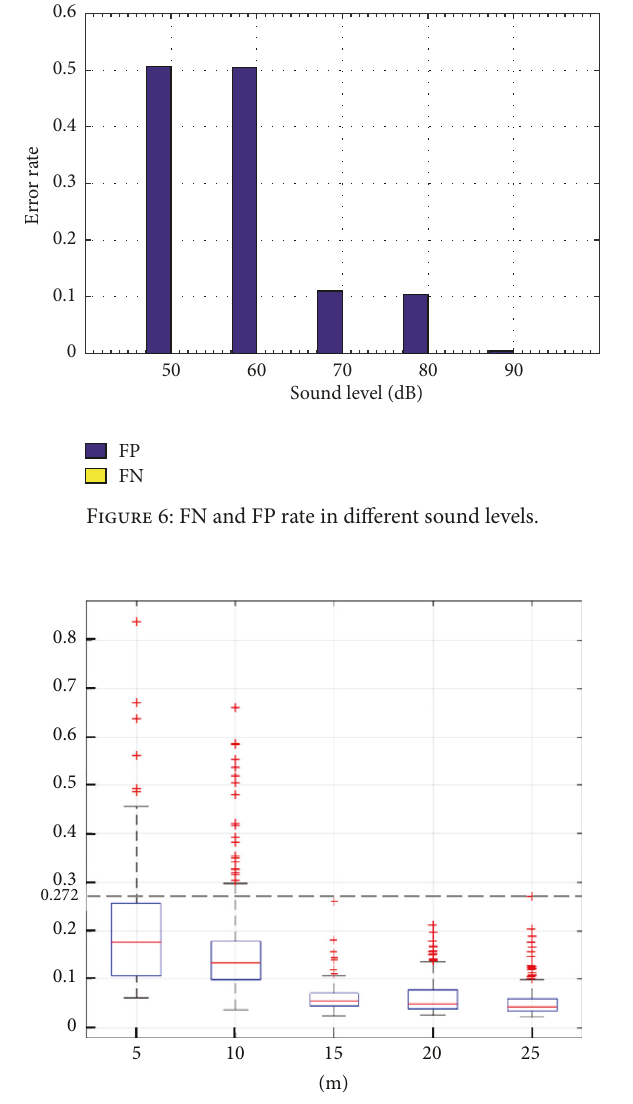
Figure 7: Impact of the sound-similarity score on the distance.